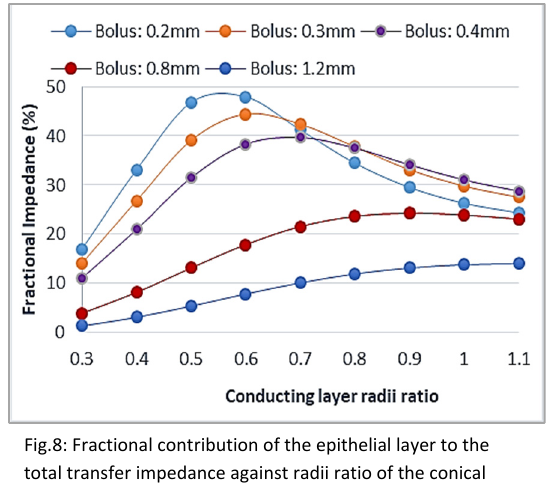
Fig.8: Fractional contribution of the epithelial layer to the total transfer impedance against radii ratio of the conical conducting layer for different conducting layer height. Edge to edge electrode separation is 1